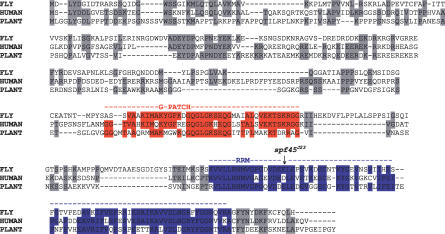

D. melanogaster SPF45 Protein Is ConservedAlignment of SPF45 proteins from D. melanogaster and humans and the DRT111 protein from A. thaliana. Identical residues are shaded. The residues that comprise the G-patch domain are shaded in red, and the residues that comprise the RRM-like motif are shaded in blue. An arrow indicates the position of the P-element insertion in spf45J23.